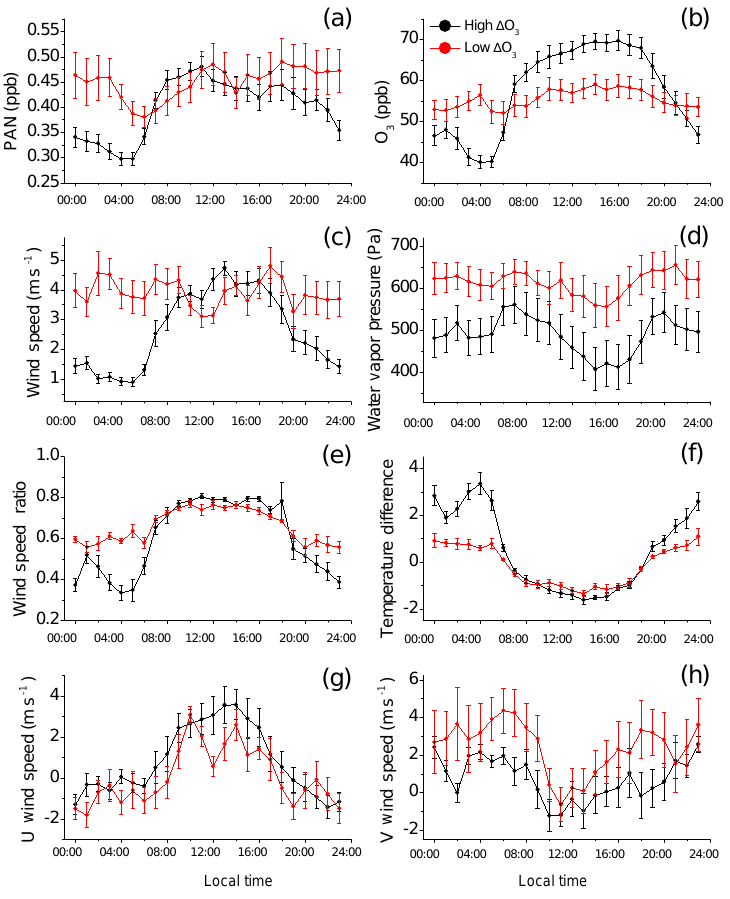
Figure 4. Diurnal patterns of PAN (a) , O 3 (b) , wind speed (c) , water vapor pressure (d) , wind speed ratio ( e , ratio of 10m height wind speed and 2m height wind speed), temperature difference ( f , subtraction of 20m height temperature and 10m height temperature), U (zonal) wind speed (g) and V (meridional) wind speed . Black curves represent diurnal curves of 15 days with greatest (cid:49) O 3 from 07:00 to 11:00LT (Group 1), and red curves represent diurnal curves of 15 days with smallest (cid:49) O 3 (Group 2). The vertical bars represent one standard error of the